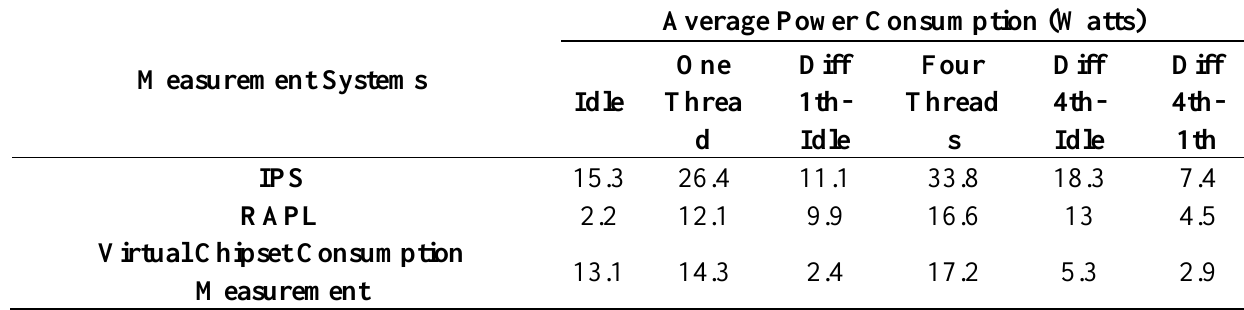
Table 2. Power consumption (Watts)